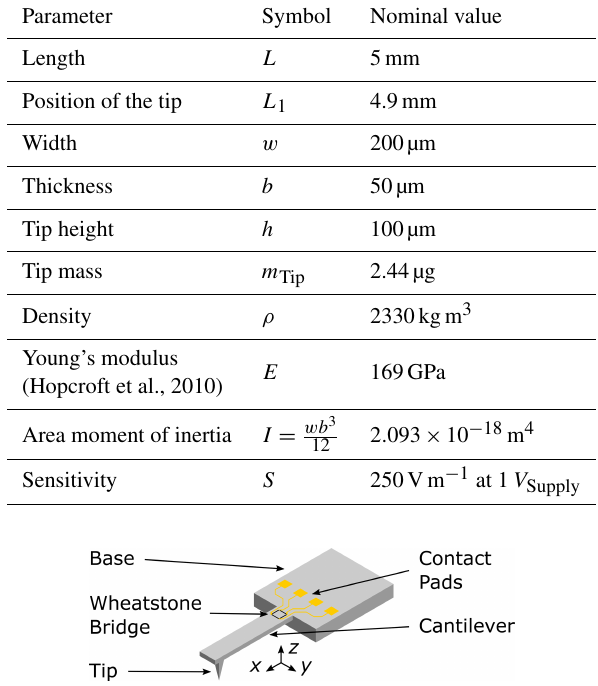
Figure 1. Schematic of the microprobe.